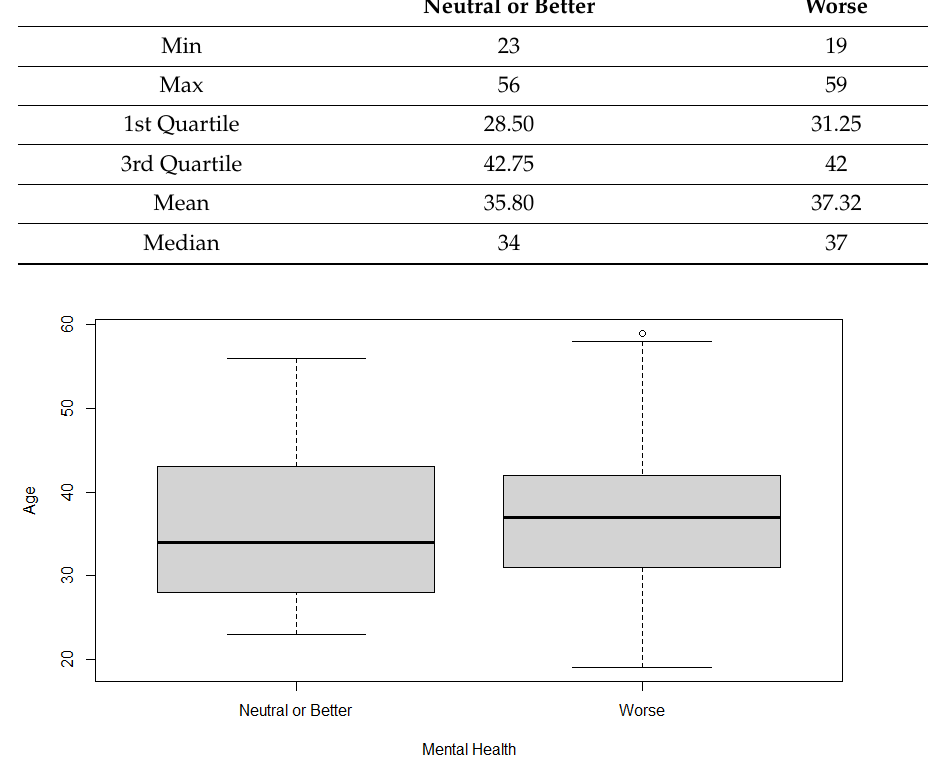
Figure 1. Boxplot of mental health different answers according to age.